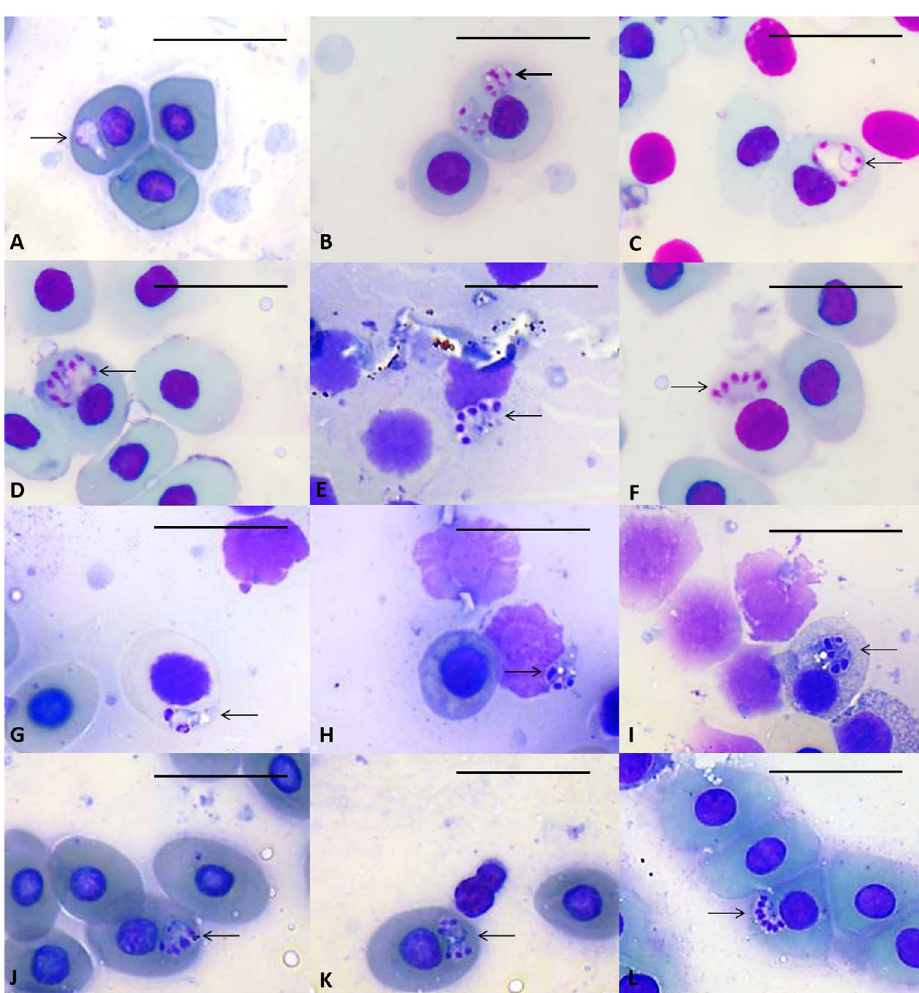
Figure 1. Dactylosoma piperis n. sp. in blood smears of Leptodactylus labyrinthicus . Primary merogony (A – F): A) Trophozoite; B) Young primary meront; C – D) Primary large rounded meronts; E – F) Fan-like shaped primary meronts with merozoites. Secondary merogony (G – L): G – H) Young secondary meronts; I – J) Secondary meronts with dactylate appearance; K – L) Secondary meronts with merozoites. Scale bar: 10 l